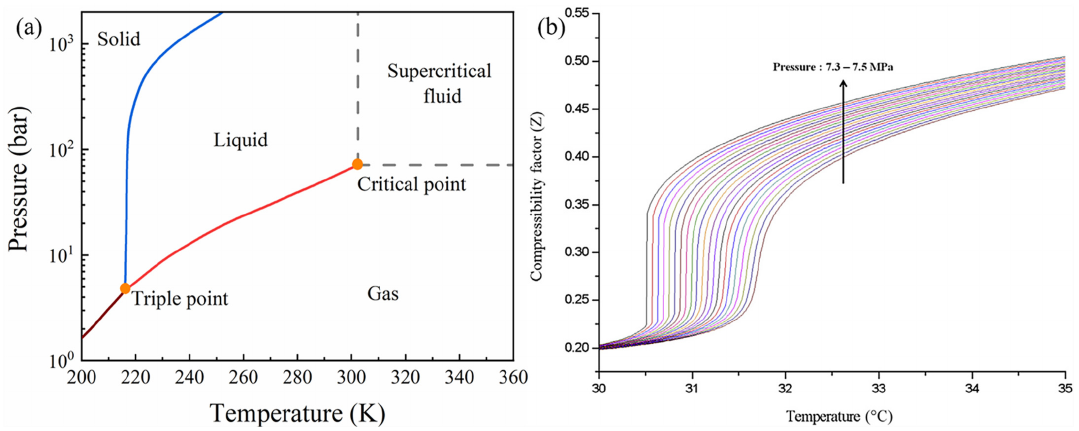
Figure 2. ( a ) Phase diagram of CO 2 . Data were obtained from reference [3]. ( b ) CO 2 compressibility factor near the critical point [2]. Reproduced with permission from Jeong Ik Lee (corresponding author).